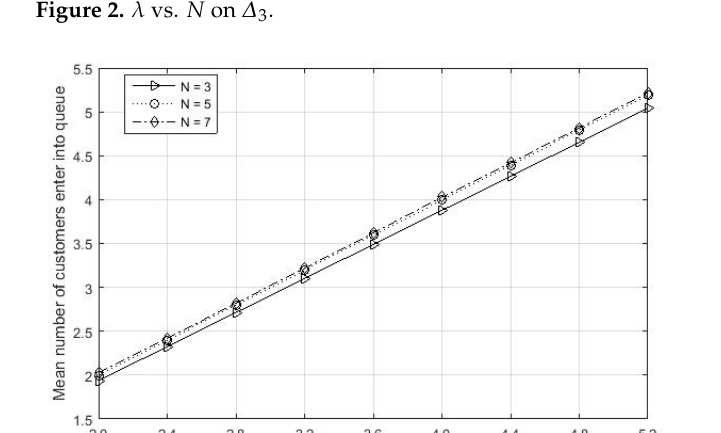
Figure 2. λ vs. N on ∆ 3 .